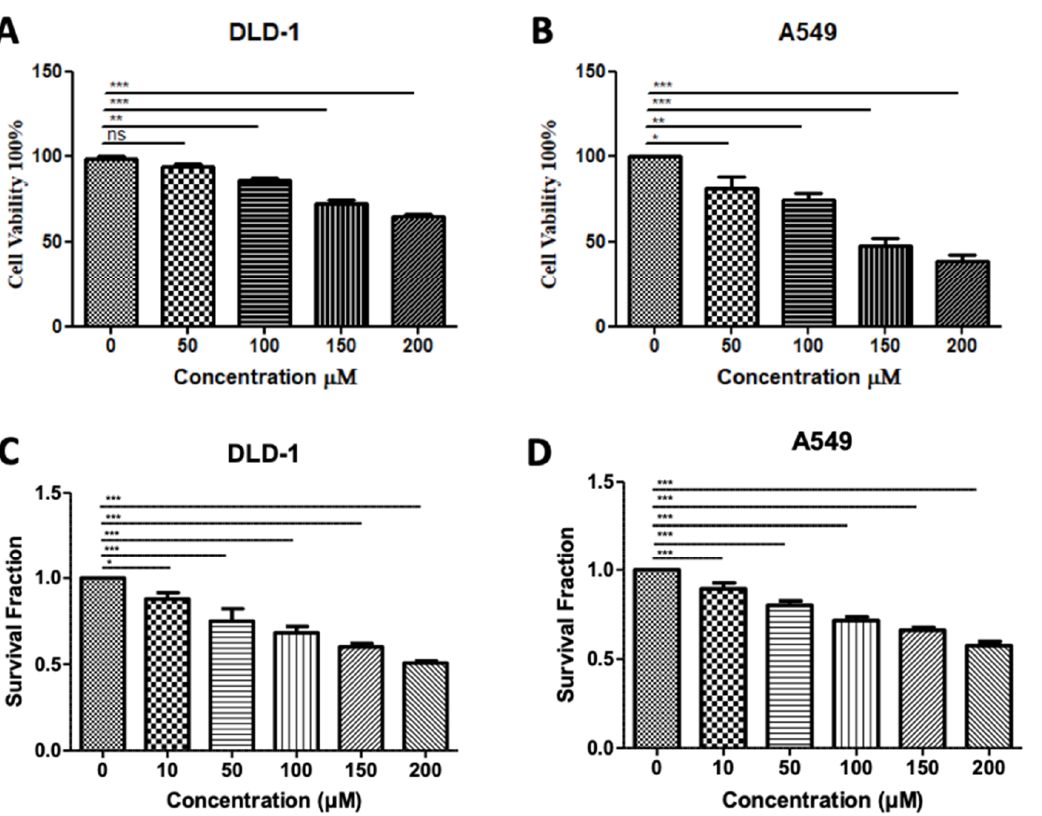
Figure 6. Treatment with SMYD3 Inhibitor-4 reduces carcinoma cell viability and proliferation. Cell viability of DLD-1 colorectal cancer cells ( A ) and A549 lung cancer cells ( B ) after 48 h of treatment with various concentrations. Survival fraction/proliferation of DLD-1 cells ( C ) and A549 lung cancer cells ( D ) after two weeks of treatment with various concetnratons of Inhibitor-4. Statistically significant differences from control are indicated by * p < 0.05, ** p < 0.01, *** p < 0.001 or ns p >